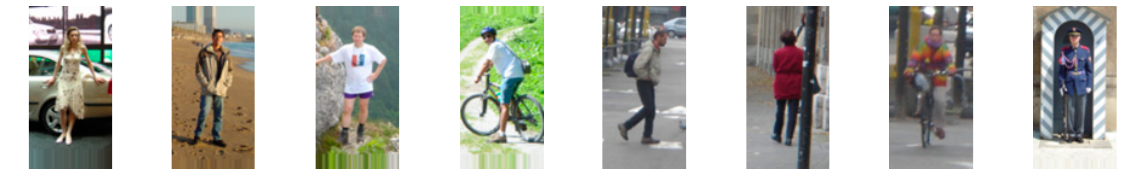
Figure 4. Some samples of INRIA dataset.